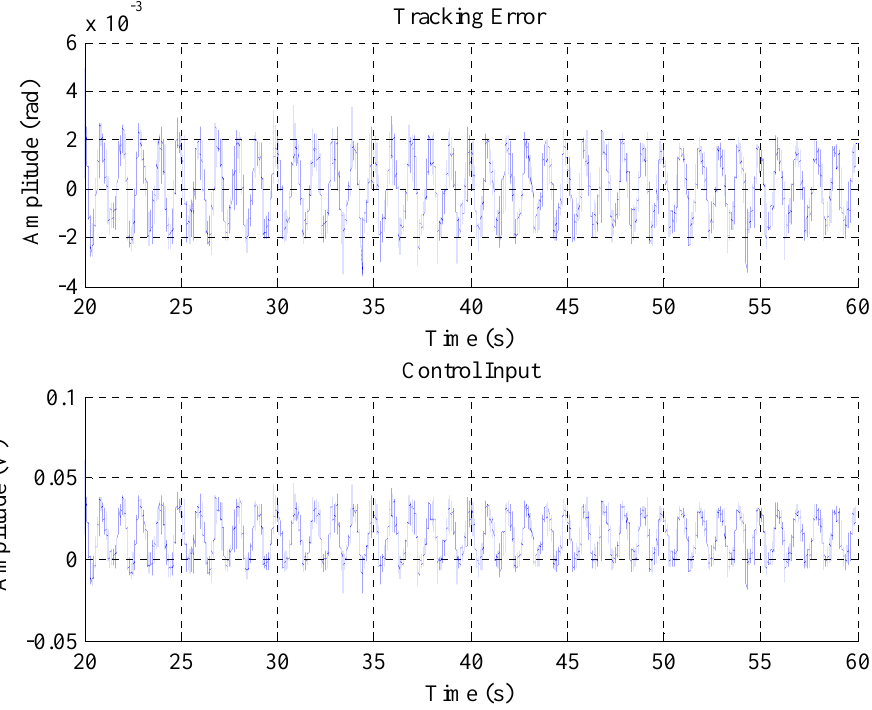
Figure 10. Periodic tracking results of the Yaw axis motor: tracking error ( top ); and control input ( bottom ).